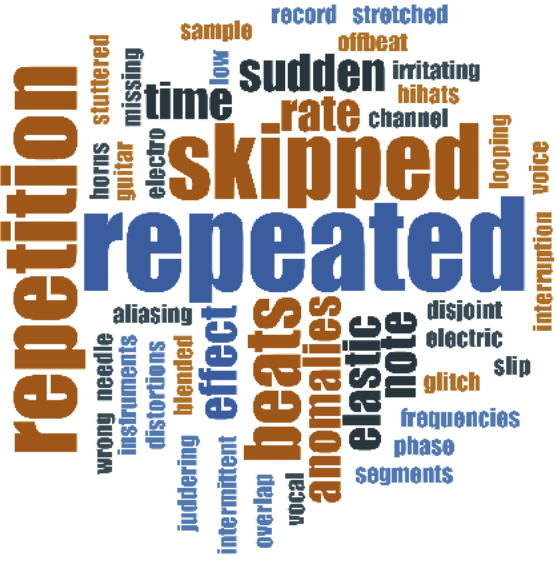
Figure 9: Word cloud of participants' time theme